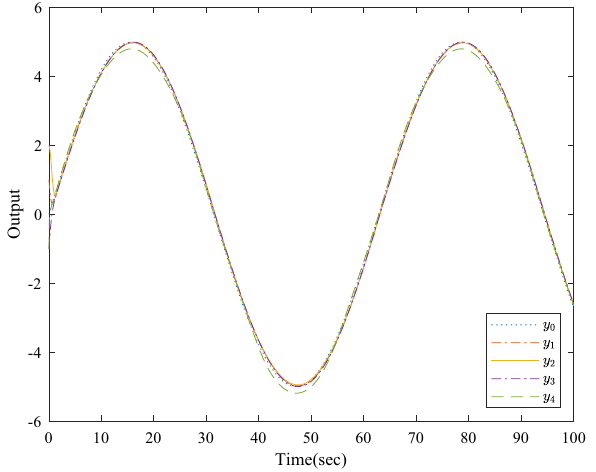
Figure 4. Output of five